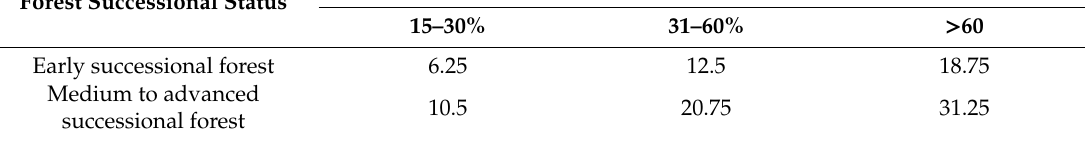
Table A2. Values for payment for ecosystem services (USD. ha-1. year-1) to landowners for forest conservation practices in the Water Producer Project at the Piracicaba, Capivari, and Jundiai Watershed, Atlantic Forest, Brazil. 1 USD = BRL 4 (November, 2019). APP: riparian areas of permanent protection according to the Brazilian native vegetation protection